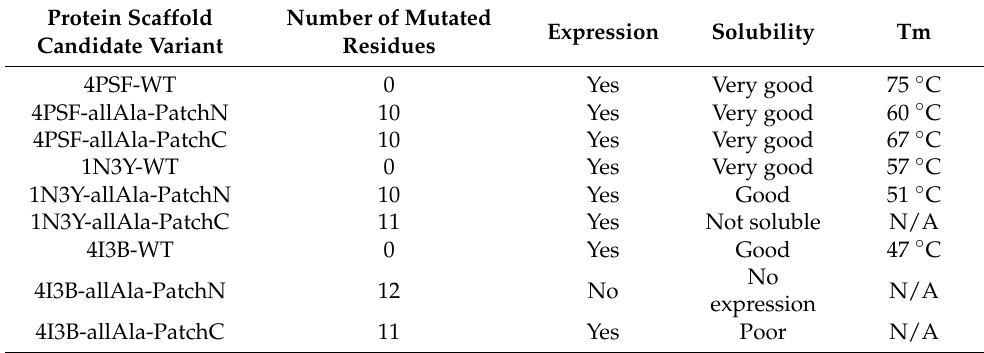
Table 2. Properties of three most promising wild-type (WT) protein scaffold candidates and their allAla variants. The melting temperatures (Tm) were measured by circular dichroism. Protein Scaffold Number of Mutated Expression Solubility Tm Candidate Variant Residues 4PSF-WT 0 Yes Very good 75 ◦ C 4PSF-allAla-PatchN 10 Yes Very good 60 ◦ C 4PSF-allAla-PatchC 10 Yes Very good 67 ◦ C 1N3Y-WT 0 Yes Very good 57 ◦ C 1N3Y-allAla-PatchN 10 Yes Good 51 ◦ C 1N3Y-allAla-PatchC 11 Yes Not soluble N/A 4I3B-WT 0 Yes Good 47 ◦ C 4I3B-allAla-PatchN 12 No